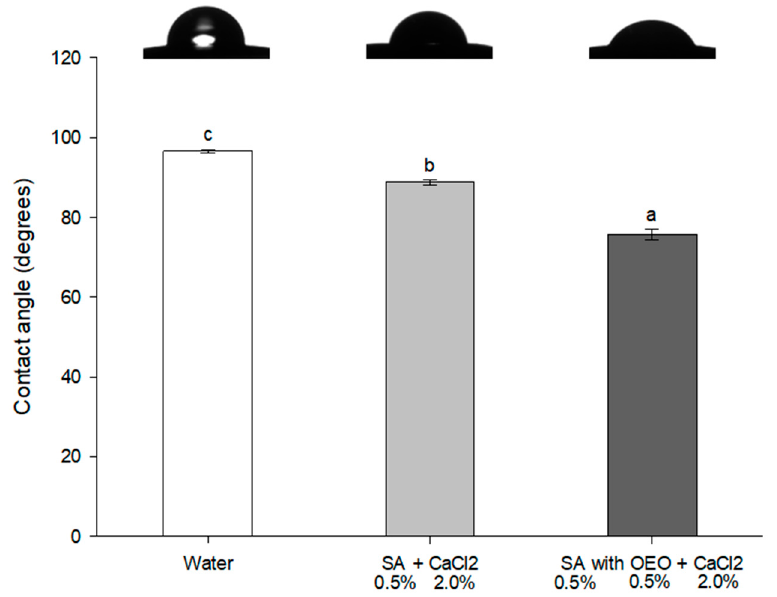
Figure 6. Average contact angle of water and coating solutions with or without OEO. Di ff erent letters denote significant di ff erences ( p <